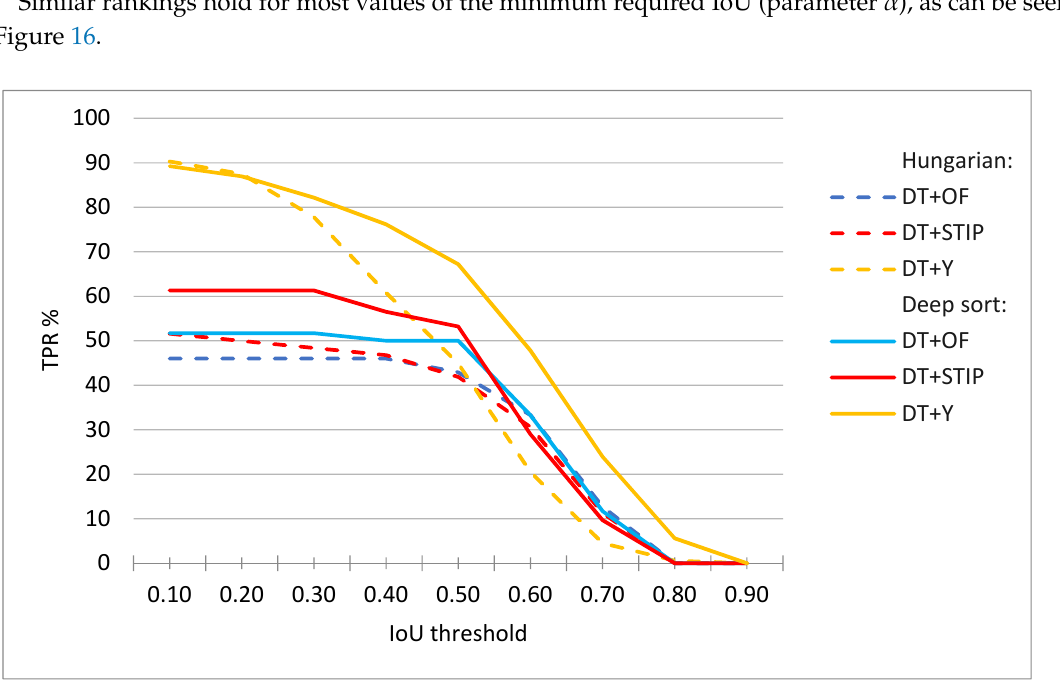
Figure 16. Evaluation results for player tracks obtained with DT+OF, DT+STIP, and DT+Y activity measures using Deep sort or Hungarian algorithm for tracking. The results at minimum 𝜃 = 70% correct frames per sequence. In the following, some typical cases and issues are shown and commented on. Figure 17 shows a collage of thumbnails that present good examples of player tracks that include all correctly detected bounding boxes on the frames in the sequence. As each player performs a particular action in a